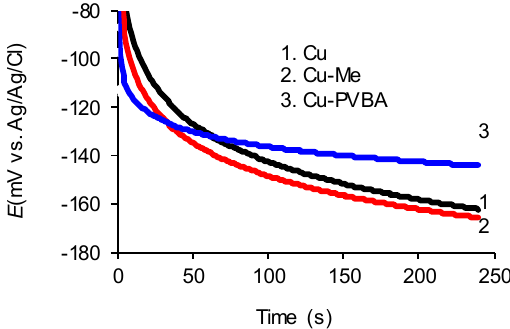
Figure 1. Variation of the open-circuit potential for standard copper, methanol-treated copper, and poly (vinyl butyral-co-vinyl alcohol-co-vinyl acetate) (PVBA) modified copper, recorded in 0.9% NaCl solution.